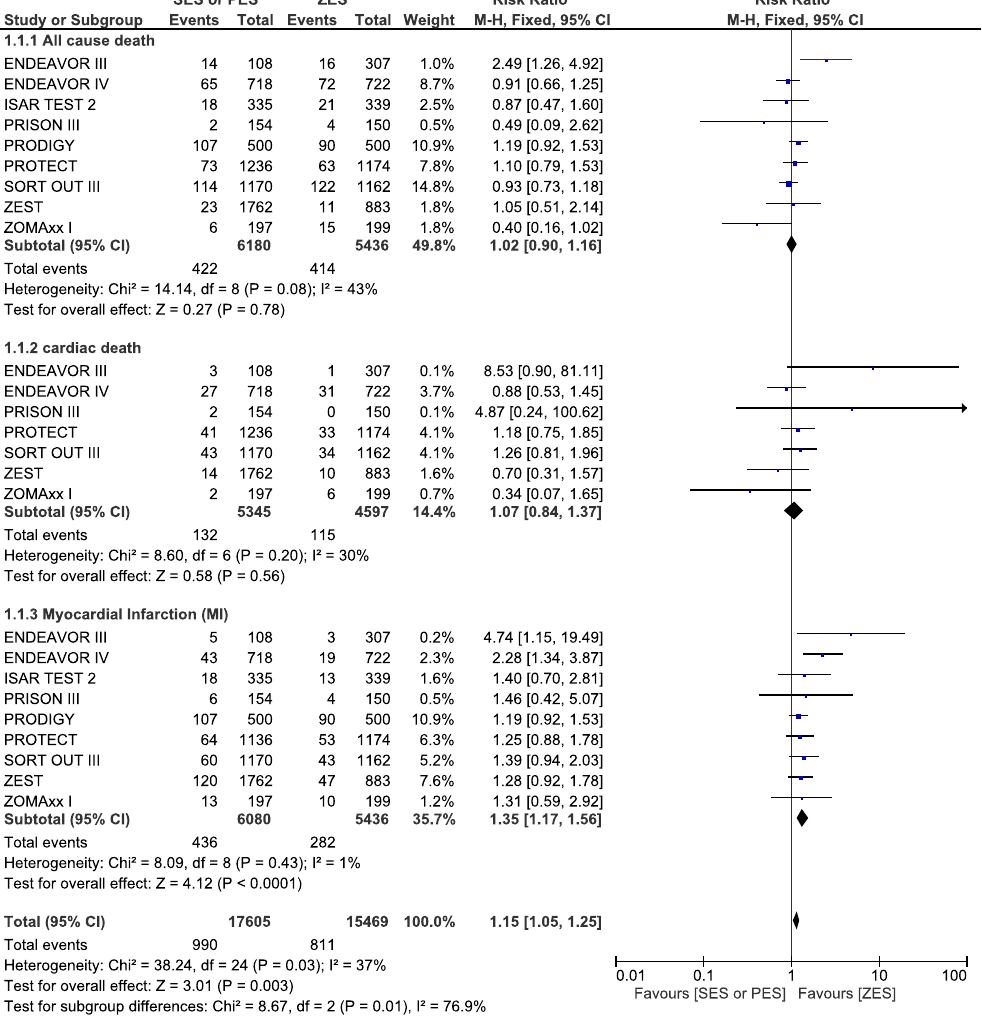
Figure 3. Long term Mortality and Myocardial Infarction which were associated with ZES versus SES or